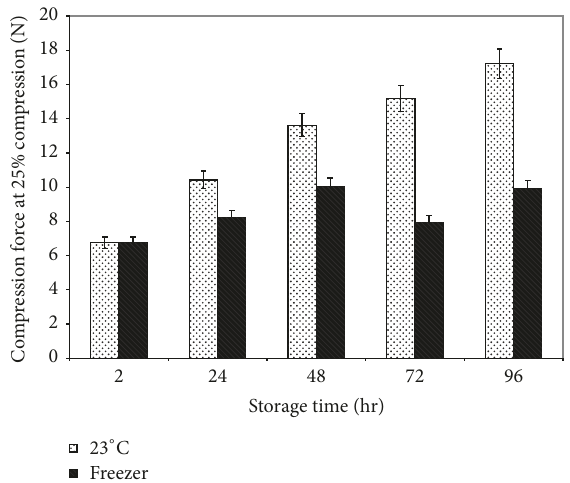
Figure 4: Relationship between compression forces at failure and storage time at 23 ∘ C (room temperature) and − 18 ∘ C (freezer temperature) for pita bread (source: 4th